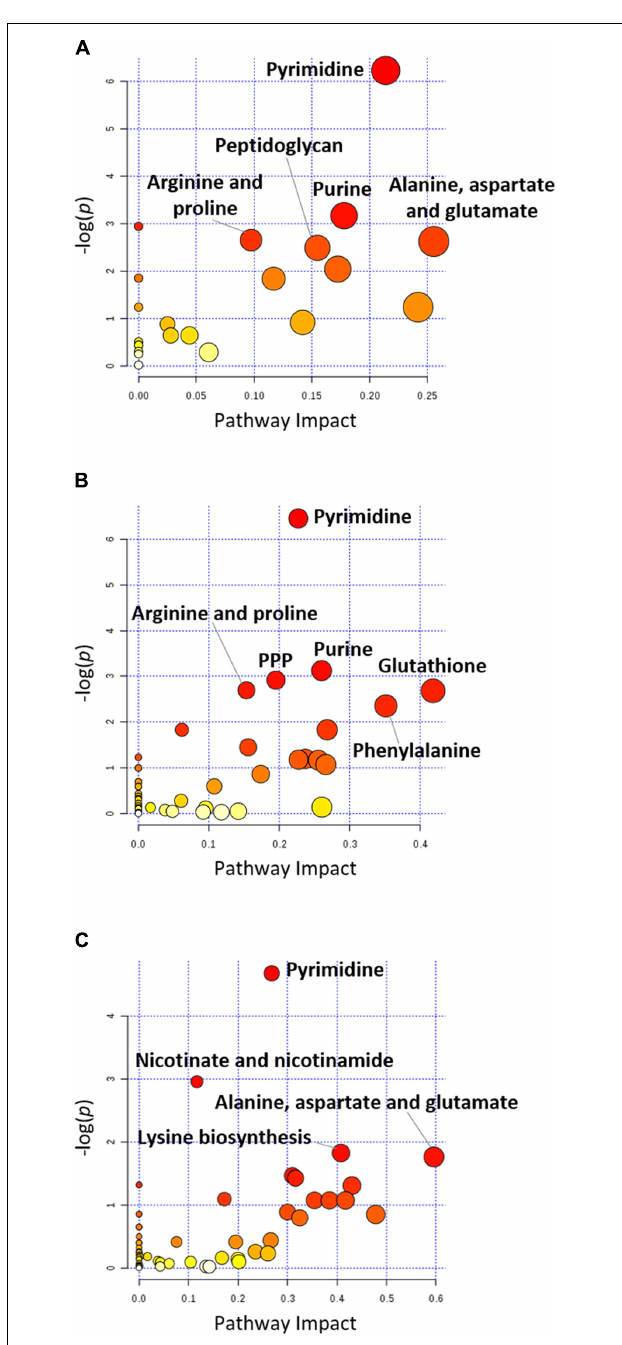
FIGURE 4 | Pathway analysis of significantly affected metabolites in A. baumannii AB090342 following the treatments with colistin, aztreonam alone and the combination at (A) 1 h, (B) 4 h, and (C) 24 h (FDR < 0.05, p < 0.05 and FC ≥ 2, one-way ANOVA). The pathway enrichment analysis was based on KEGG Pathway (http://www.genome.jp/kegg/pathway.html) with reference to Escherichia coli K-12. The figure was generated by MetaboAnalyst 4.0